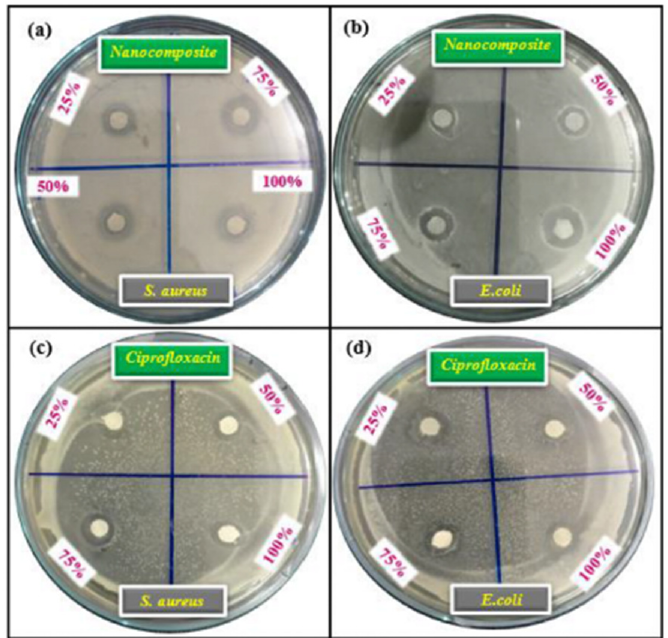
Figure 20. Antibacterial effect of ZnO-CeO 2 -Yb 2 O 3 nanocomposites: ( a ) gram-positive Staphylococcus aureus bacteria, ( b ) gram-negative Escherichia coli bacteria at different concentrations, and ( c , d ) Standard antibiotics Ciprofloxacin against S. aureus and E. coli . Reprinted/adapted with permission from Ref. [203]. Copyright© 2022, Elsevier Masson SAS.